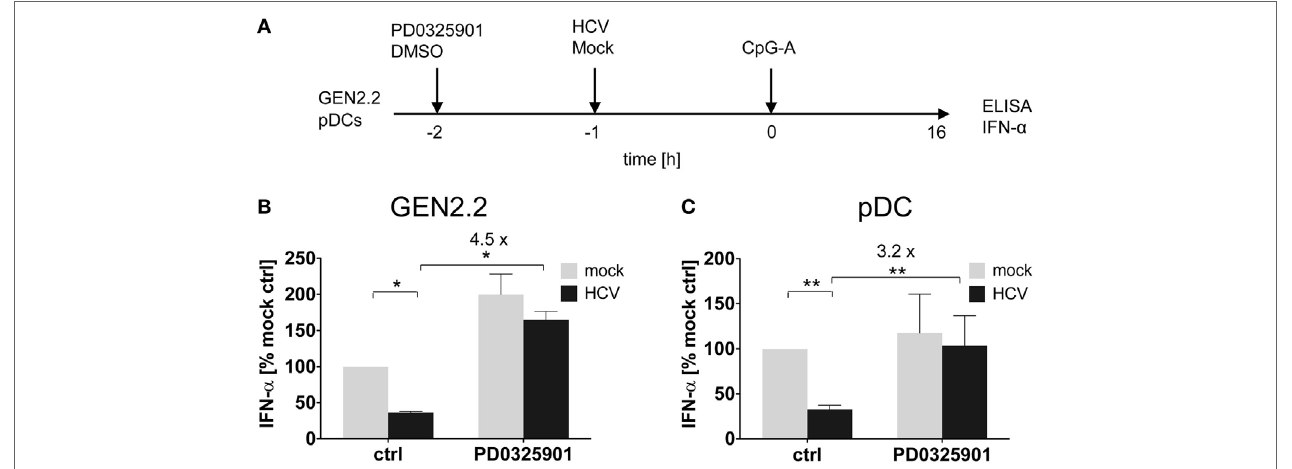
FigUre 4 | Effect of MEK1/2 inhibition on the hepatitis C virus (HCV) blockade of IFN- α in GEN2.2 cells or primary plasmacytoid dendritic cells (pDCs). (a) Experimental outline. GEN2.2 cells separated from MS-5 feeder cells (B) , or primary pDCs (c) , were incubated with 1 µM MEK1/2 inhibitor PD0325901 for 1 h and then treated with HCV virions at MOI = 10 geq/cell for 1 h before CpG-A stimulation. After a 16 h culture, the IFN- α production was determined in the cell-free supernatants by ELISA. (B,c) The IFN- α production was normalized to the level induced by CpG-A in the presence of a mock-infected control and in the absence of PD0325901. The data show mean ± SEM of (B) two independent experiments with GEN2.2 cells, *, p < 0.05; unpaired, two-tailed t -test and (c) ten independent experiments with primary pDCs from different healthy donors, **, p < 0.01; two-tailed paired Wilcoxon